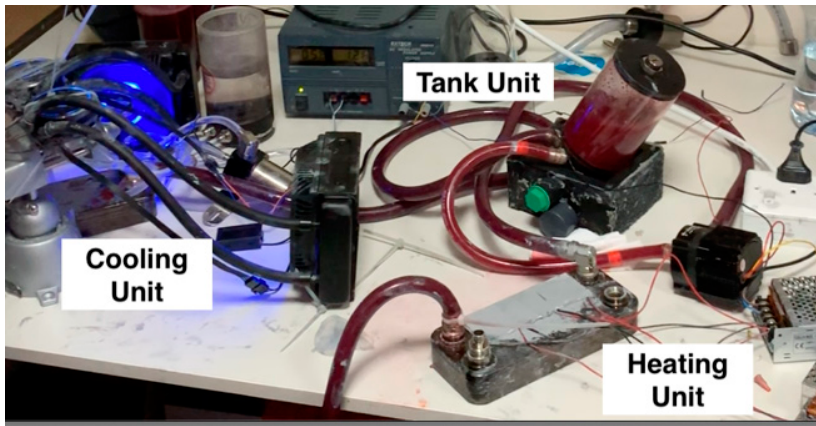
Figure 17. Current prototype of thermochromic heater-cooler system.